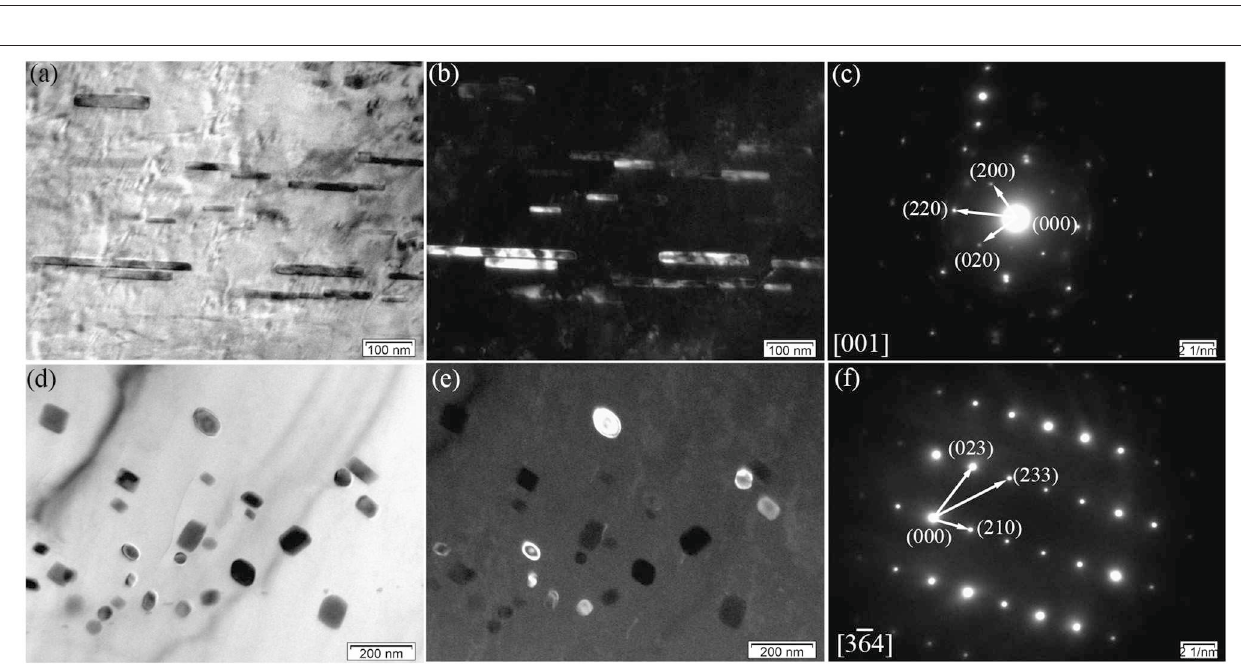
FIGURE 7 | Microstructure of the E350 sample: (a) BF image; (b) Corresponding SAED pattern.